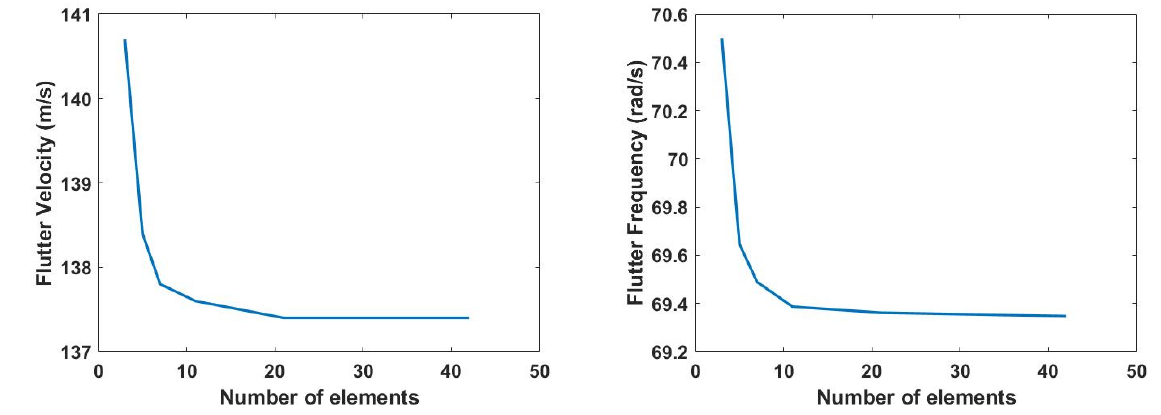
Figure 6. Convergence study performed for the finite element model with 1 element for adjoining torsional spring and an equal number of elements for inboard and outboard wing sections.